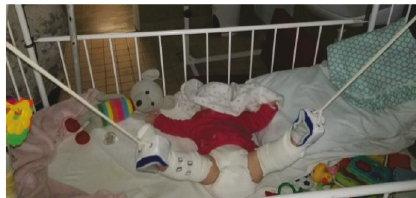
Figure 3: Overhead traction.